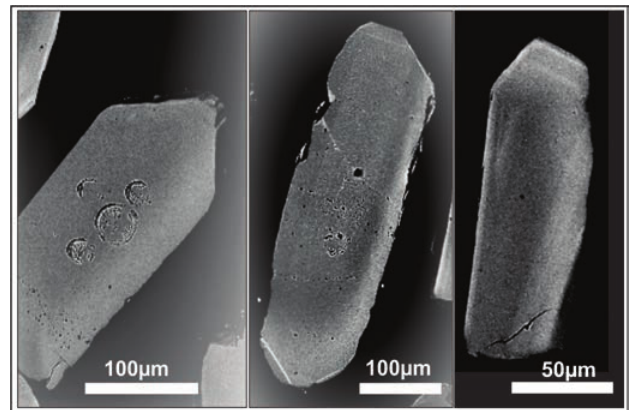
Figure 14 - Backscattered electron images of microaugen gneiss zircons emphasizing well-developed and prismatic shapes, clear crystals without metamorphic overgrowth rims (sample AR-62C).